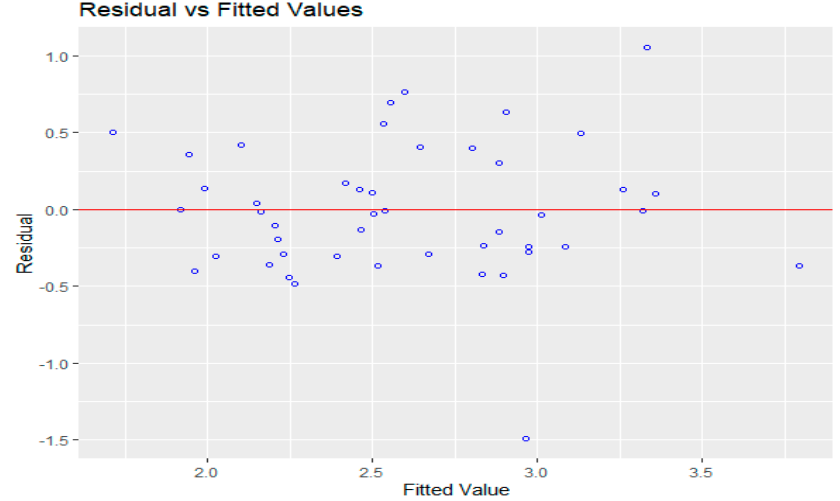
Figure 7. Regression residual plots.